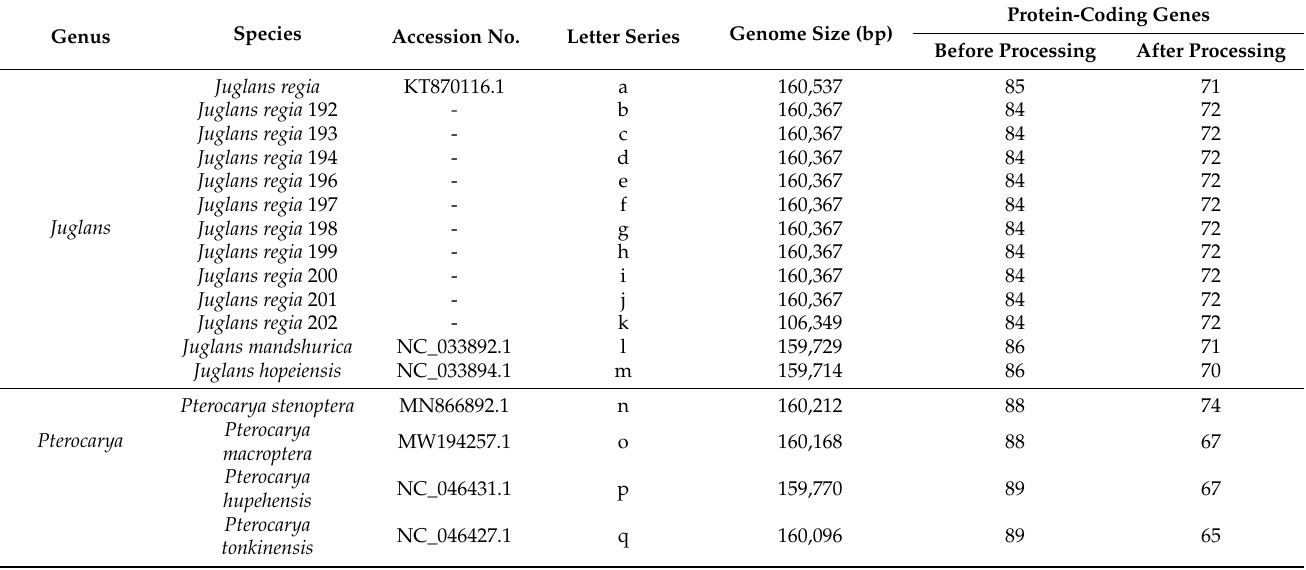
Table 1. Chloroplast genomes and the associated information of 26 Juglandaceae